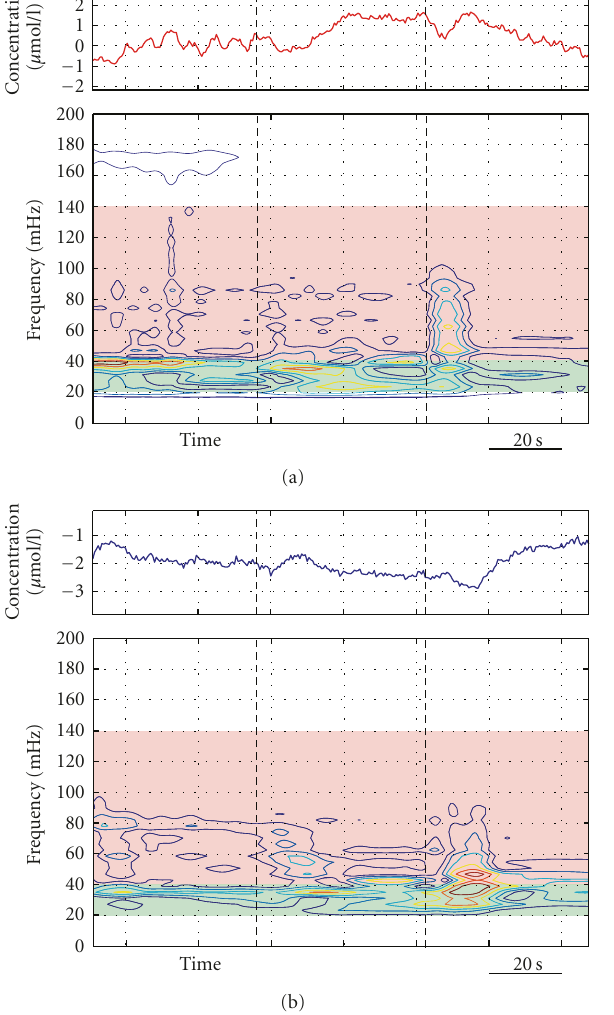
Figure 4: Time-frequency representations of O 2 Hb (a) and HHb (b) concentration signals during BH. The graphs are relative to a subject su ff ering from migraine without aura. The vertical dashed lines mark the BH onset and o ff set. The red rectangle indicates the LF band (40–140 mHz), the green the VLF band (20–40mHz). It is possible to notice that BH seems to decrease the spectral content of the signals in the LF